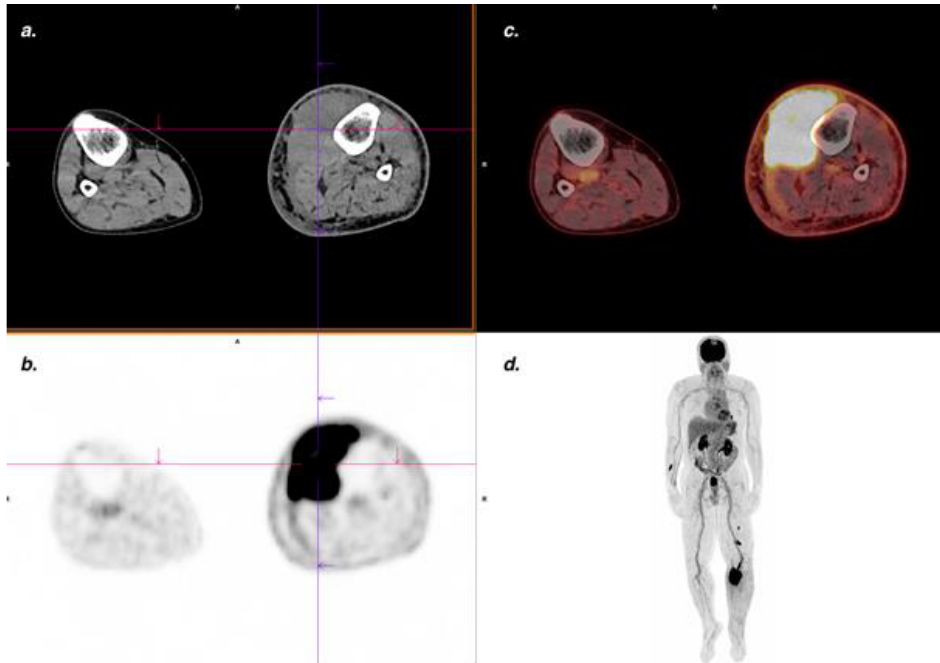
Figure 5. Endemic KS. Suspected clinical recurrence with increased lymphedema of left lower limb. The FDG PET/CT showed a voluminous, intensely hypermetabolic (SUV max 26.7) intramuscular lesion confirmed by MRI and pathological analysis. ( a ). CT transaxial slice; ( b ). PET transaxial slice; ( c ). Fused PET/CT transaxial slice; ( d ). Maximum intensity projection (MIP) PET images.